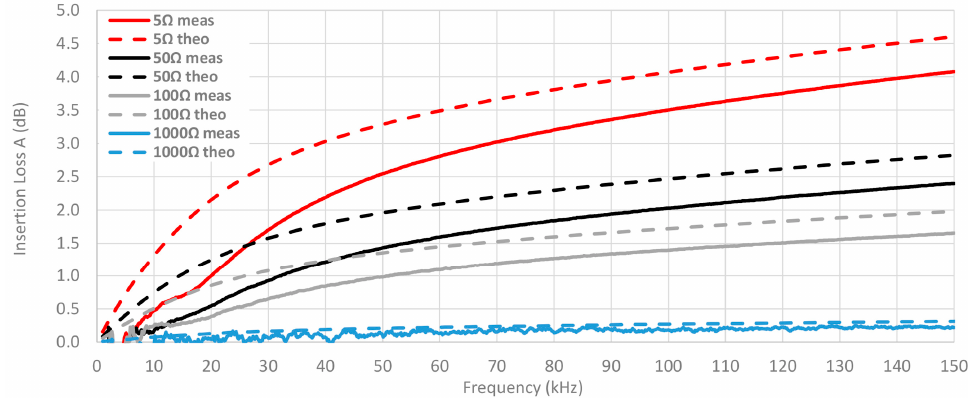
Figure 19. Comparison between experimental and theoretical insertion loss of NC cable ferrite depending on the load by winding 1 turn.